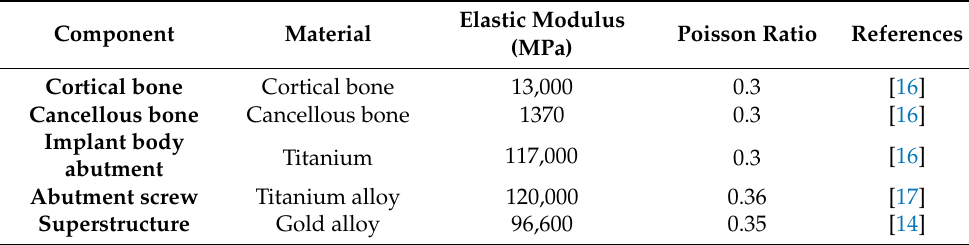
Table 1. Mechanical properties used for the three-dimensional finite element analysis model.